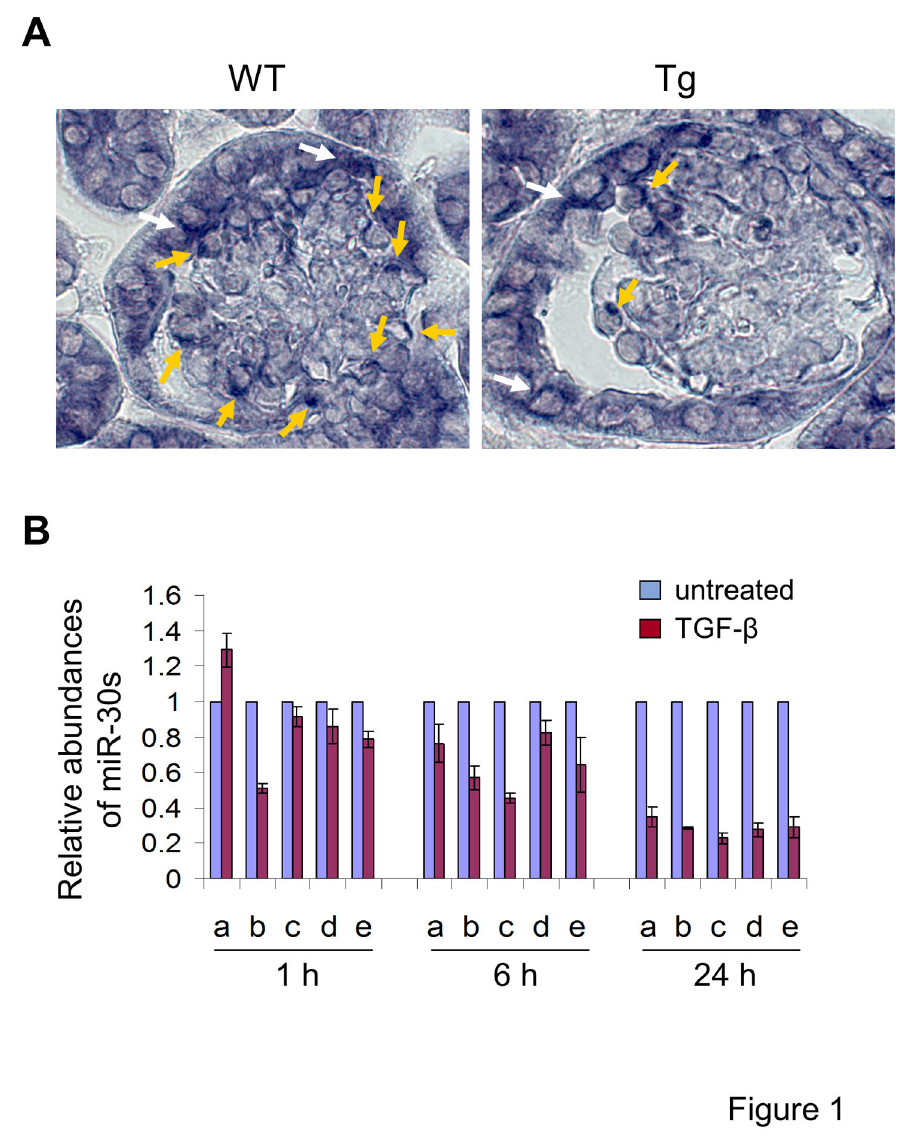
Figure 1. miR-30s are downregulated by TGF-β in glomerular podocytes in vivo and in vitro . A . miR-30d transcripts were abundantly detected by in situ hybridization in podocytes (yellow arrows) and parietal epithelial cells (white arrows) in adult wildtype (wt) control mice, but not in Alb-TGF-β transgenic (Tg) mice; B . miR-30a, -30b, -30c, -30d, and -30e were significantly downregulated in cultured human podocytes after 6 and 24 hr of TGF-β treatment (5 ng/ml). Bar graph shows the mean ± S.D. of the relative abundance of miR-30 members in podocytes untreated (white bars) and treated (black bars) with TGF-β for 1, 6, and 24